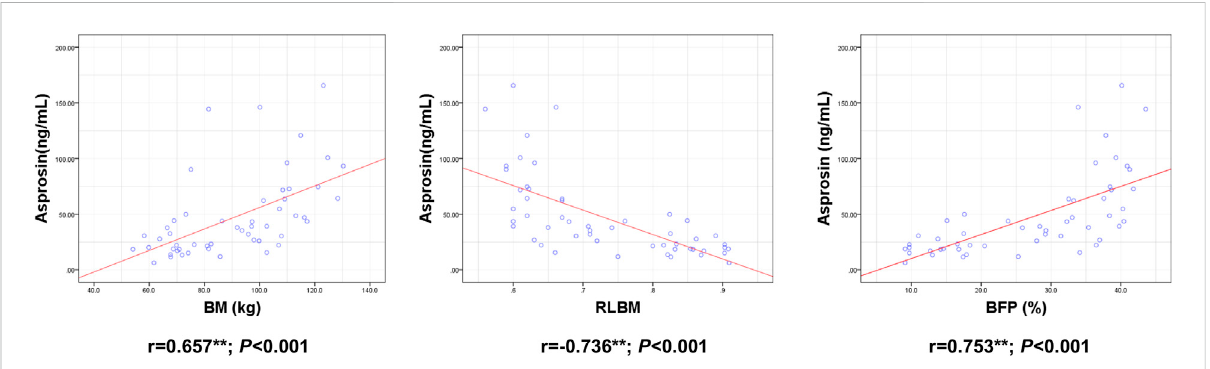
FIGURE 3 Correlation between Serum asprosin and body composition. r-correlation coef fi cient, p < 0.05 — level of statistical signi fi cance.